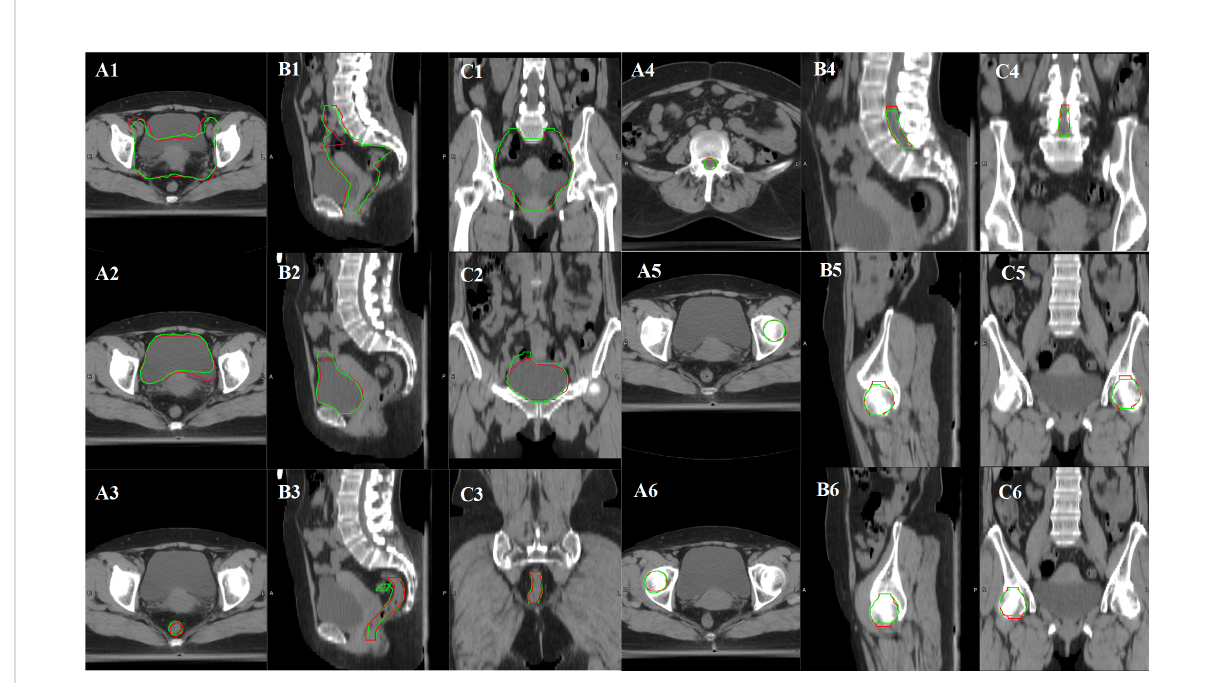
FIGURE 1 Variance between manual contours and ABAS automatic contours in CTV and OARs of cervical cancer patients with an atlas library size of 20 ( A1, B1, C1 : CTV contour comparison, A2, B2, C2 : bladder contour comparison, A3, B3, C3 : rectum contour comparison, A4, B4, C4 : spinal cord comparison, A5, B5, C5 : femoral head-L contour comparison, A6, B6, C6 : femoral head-R contour comparison. Manual contours in red color, and automatic contours in green